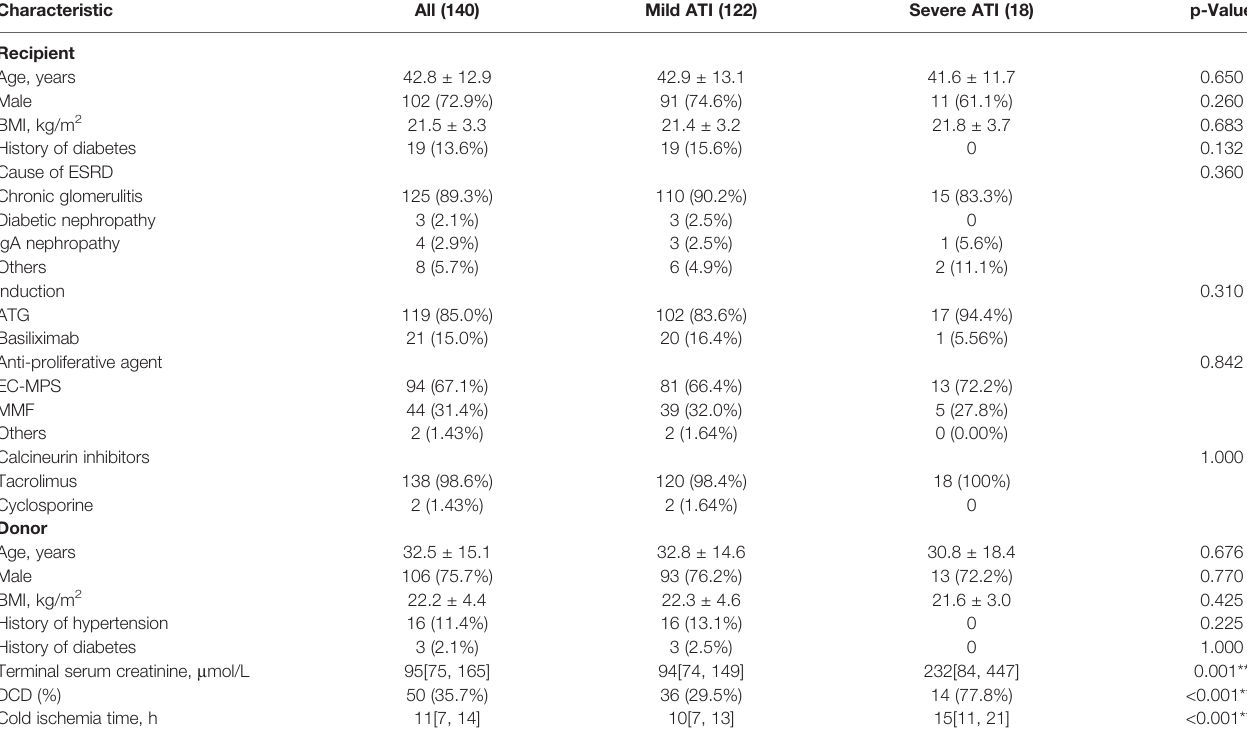
TABLE 1 | Demographics and characteristics of donors and recipients.